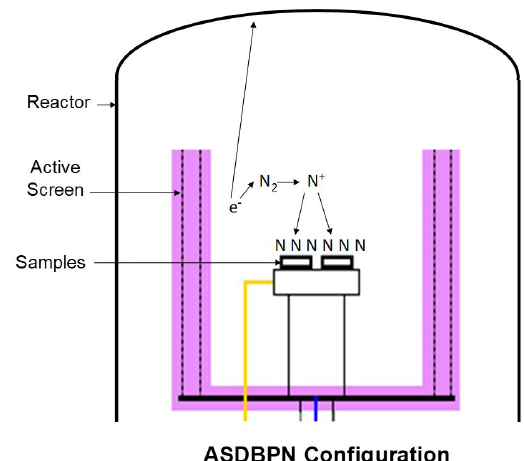
Figure 7. XRD patterns of DCPN, ASDBPN, ASPN, ASBBPN plasma nitrided sample surface and M2 not nitrided sample surface. Figure 8. ASDBPN nitriding